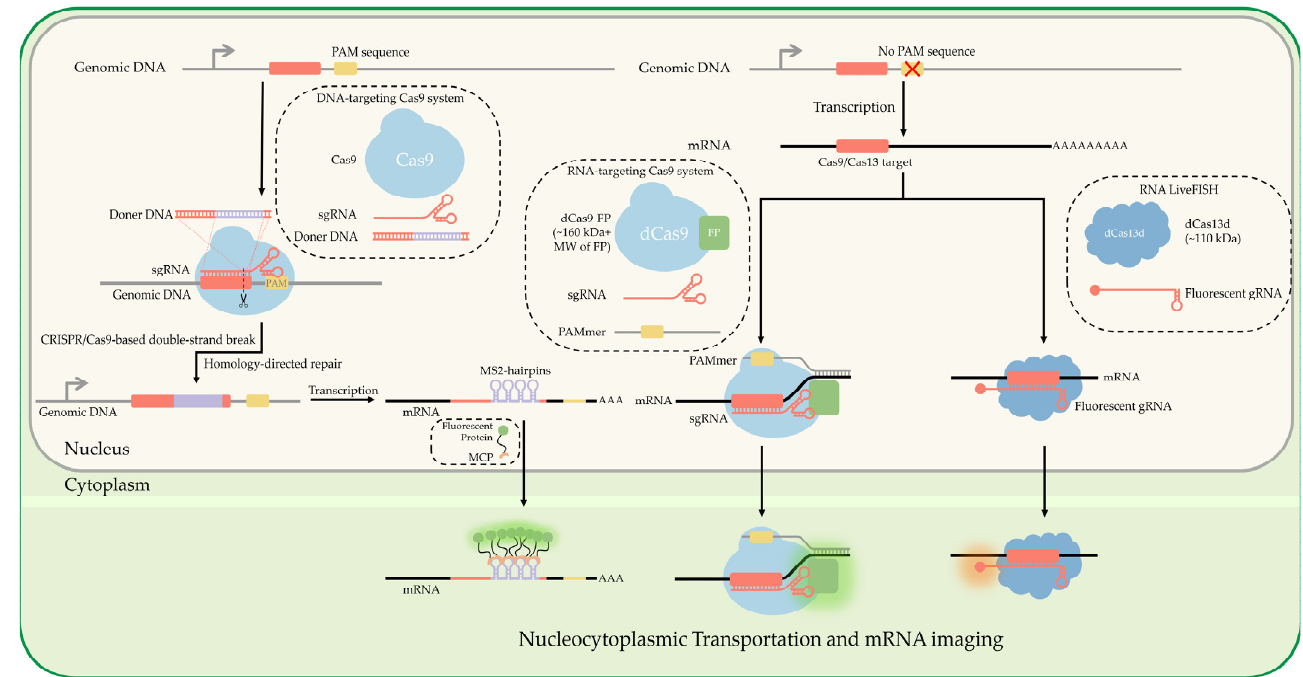
Figure 5. Nucleocytoplasmic transportation and mRNA imaging utilizing CRISPR. CRISPR/Cas9 is guided to DNA via sgRNA and neighboring PAM. Nuclease activity of Cas9 makes a double- stranded break, allowing for insertion of targeting aptamers such as MS2 hairpin loops, and for a fluorescent protein fused to MCP to label the modified mRNA. A nuclease deficient Cas (dCas) protein fused with a fluorescent protein can be used to bind to mRNA of interest directly instead, without genetic modification. By providing a double-stranded PAMmer with dCas9, dCas9 can be made to bind with mRNA instead of DNA. Alternatively, dCas13 natively binds to mRNA without the need for PAMmer sequence.